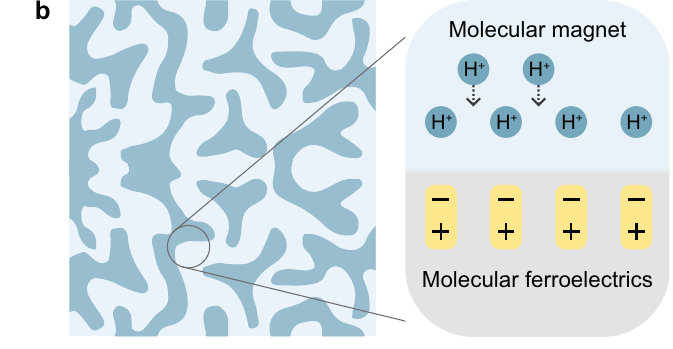
insulating as the solid crystalizes for the formation of a molecular ferroelectric matrix. Time dependence of X-ray diffraction pat- terns (XRD) shows that the diffraction intensity gradually increased, revealing the crystallization process. The insets of Fig. 3e are the real-time visualization of the crystallization pro- cess. Differential scanning calorimetry (DSC) is performed to study the phase transition behavior of IM-VH. As shown in Supplementary Fig. 9, the distinct exothermic peaks are observed at 220 K for both IM and IM-VH, implying the well crystalized IM in heterogeneous solids. The microstructure of IM-VH is further analyzed. As shown in Fig. 3f, scanning electron micro- scopy (SEM) and energy dispersive X-Ray spectroscopy (EDS) results show that the skeleton holds the as-printed heterogeneous con fi nement structure due to the elasticity of the polymer network 34 , while molecular ferroelectric and magnetic phases are uniformly distributed in the scaffold. Supplementary Fig. 10 shows the deformation-dependent fl exible IM-VH under loading as a result of the elastic framework. Raman microscopy measurements (Fig. 3g) study the IM and VH phase in the heterogeneous solids. The peaks at 622, 929, and 1097 cm − 1 represent the in-plane deformation, symmetric